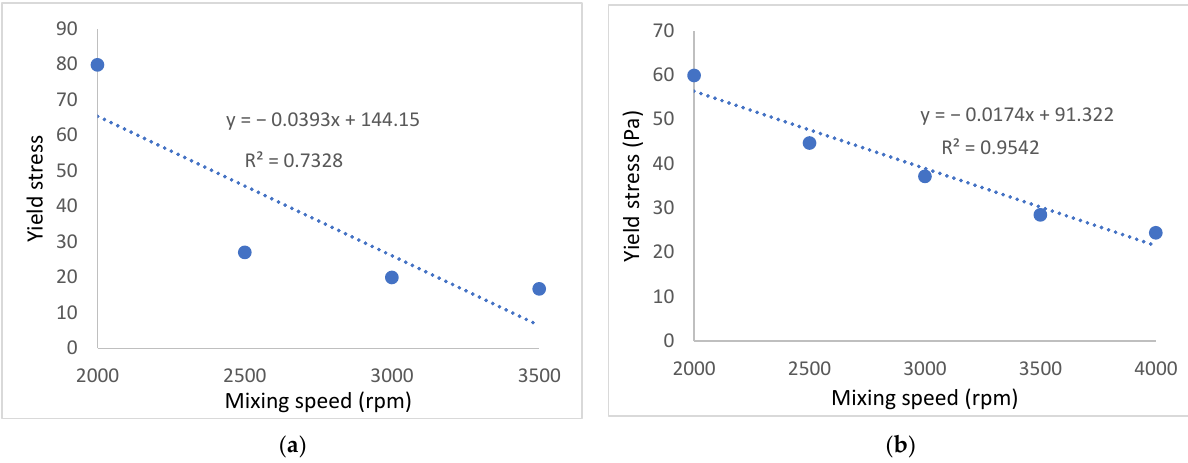
Figure 6. Yield stress trend of samples as a function of increasing mixing speed ( a ) AminoSensyl™ ( b ) CTAC.